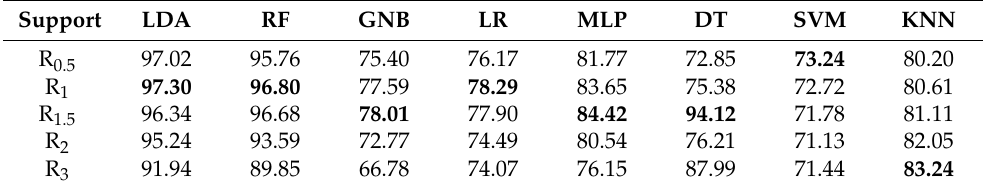
Figure 11. Classified point cloud with the lowest accuracy in the Oakland3D (66.78% with GNB in R 3 ). Table 6. The overall accuracy of the methods in Oakland3D. The highest-obtained accuracies are shown as